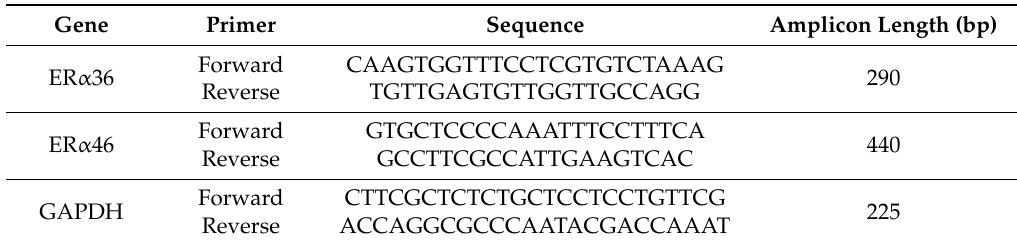
Table 4. Primer sequences and the length of the amplicons of ER α splice variants and the housekeeping